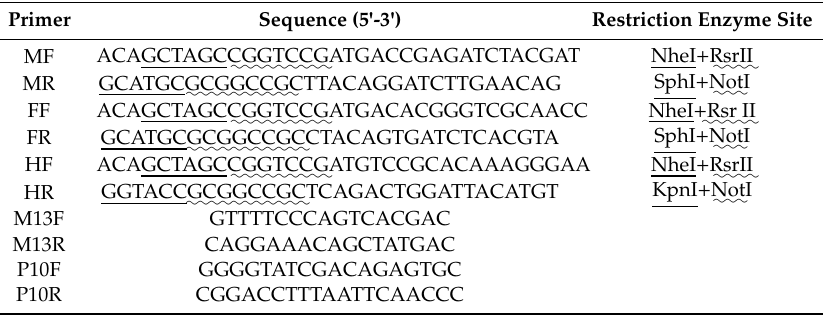
Table 1. Sequences of primers designed in our